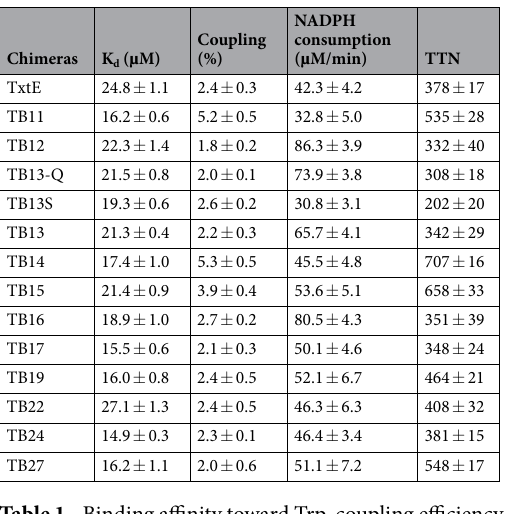
Table 1. Binding affinity toward Trp, coupling efficiency, NADPH consumption and total turnover numbers of TxtE and its chimeras. All experiments were performed at least three times.